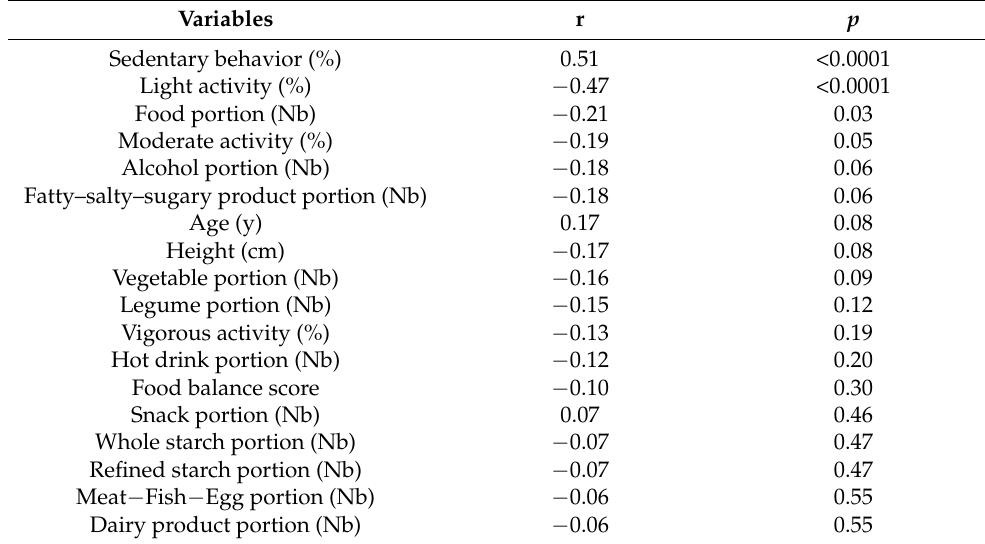
Table 3. Correlation coefficients of Pearson between BMI and individual or behavioral characteristics in the training sample (n = 108).